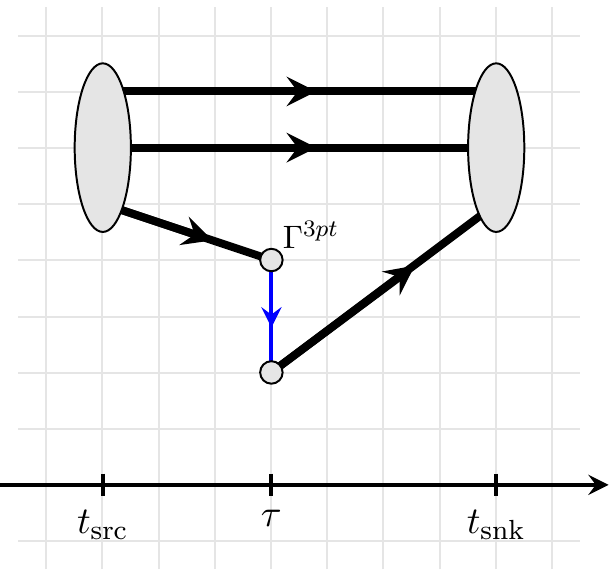
Figure 4 . Lattice nucleon three point function with the source nucleon located at t src and the sink nucleon at t separated by the distance t = t . The blue line is the Wilson line with the snk snk − t src shape shown in figure